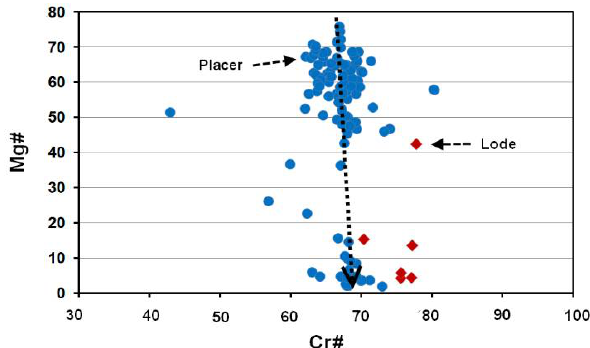
Figure 4. Plot of values of the index Mg# [100 Mg/(Mg + Fe 2+ + Mn)] vs. Cr# [100 Cr/(Cr + Al)] in compositions of placer grains of chromian spinel (chromite–magnesiochromite series) from the Sisim River system; a total of 106 data-points are plotted. For comparison, WDS data are presented for several grains of chromite collected from lode outcrops of serpentinite exposed in the area at the River Levyi Ko (this study).